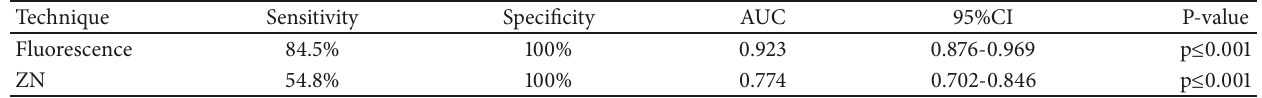
Table 4: Receiver operator characteristic (ROC) curve parameters.